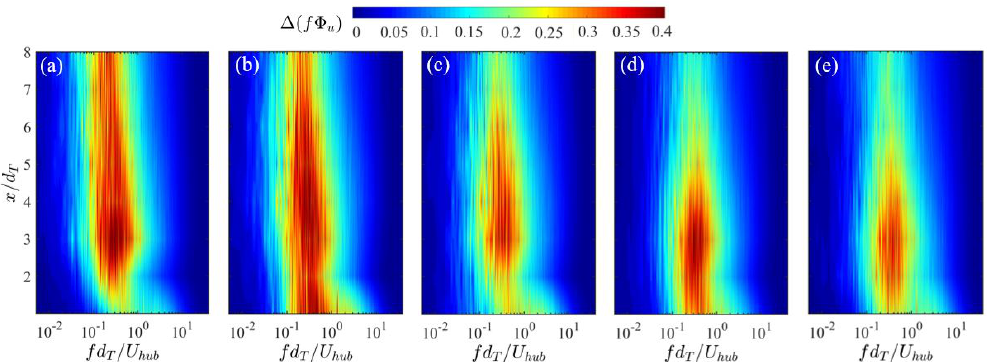
Figure 10. Compensated streamwise velocity spectral difference between various topographic steps and − f Φ ∆ the flat terrain, ∆ ( f Φ u ) = f Φ ∆ z z 0 / d T = 0 , along the rotor axis for i equal to: ( a ) 0 / d T = i ( b ) − 0.42 step; ( c ) − 0.21 step; ( d ) 0.21 step; and ( e ) 0.42